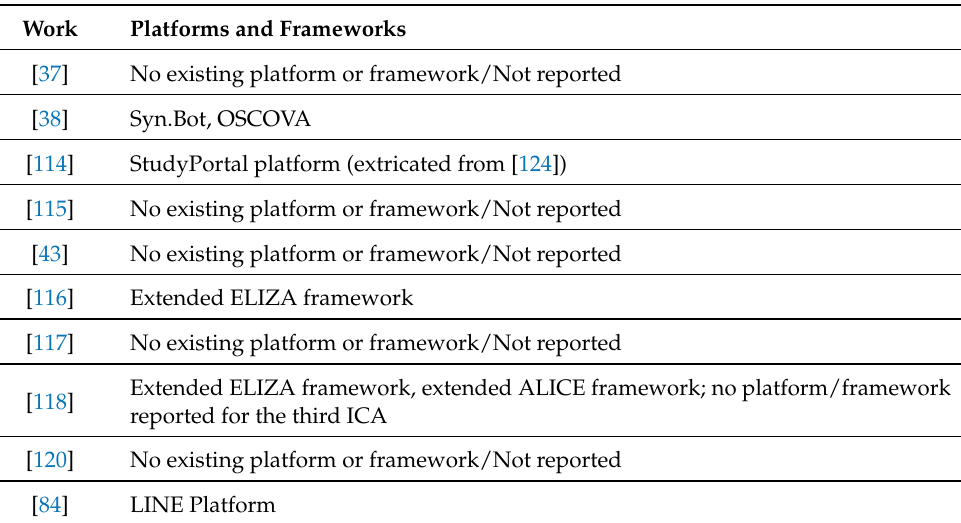
Table 5. Answering RQ4. What are the platforms used to create the